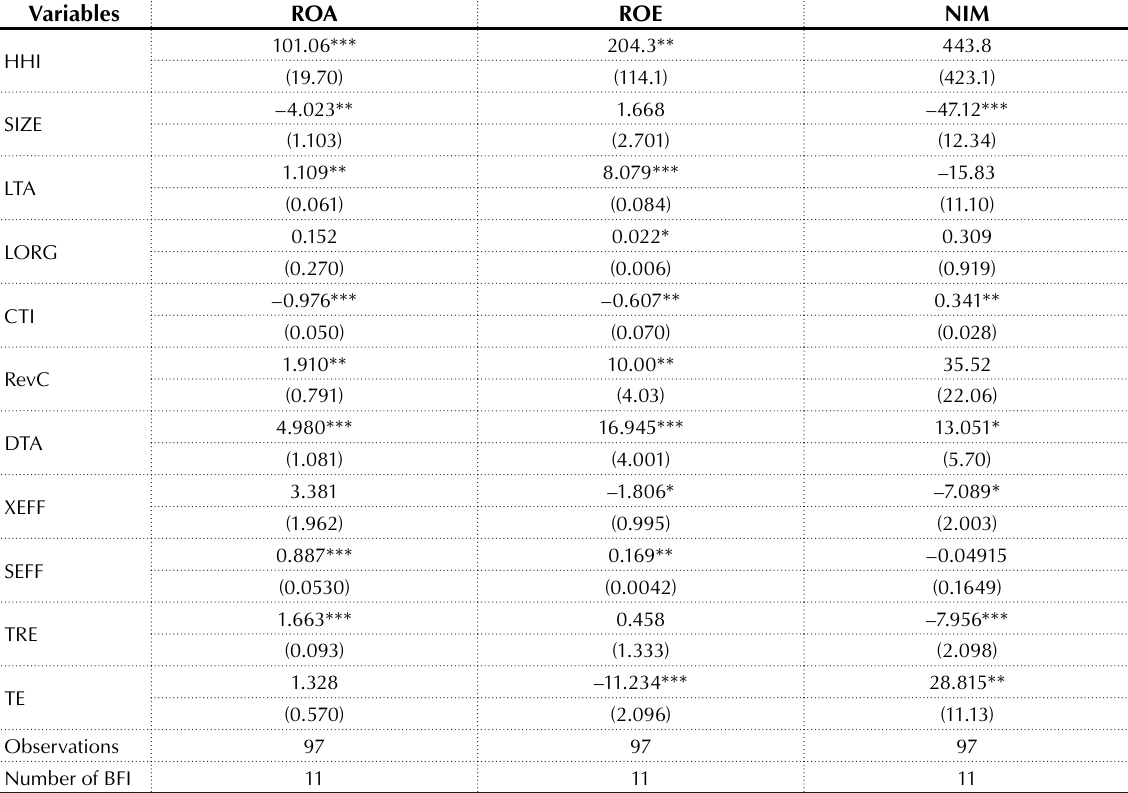
Table 2. GMM estimation results